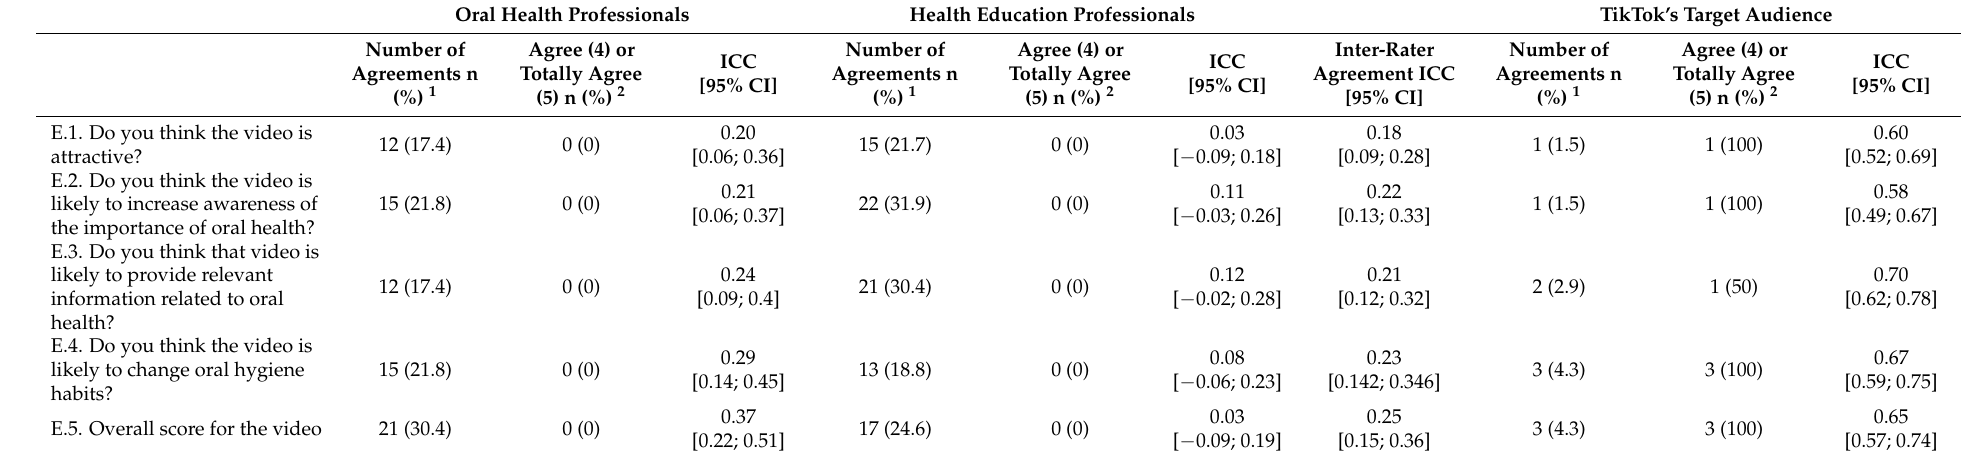
Table 6. Subjective evaluation of TikTok videos corresponding to